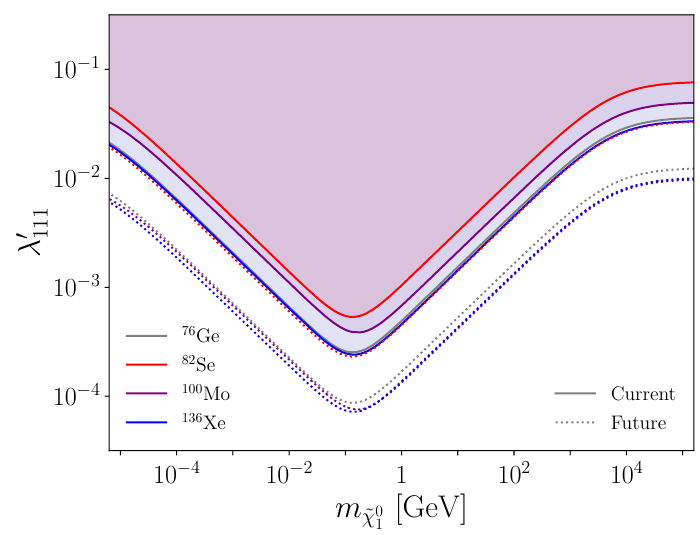
Figure 5 . Upper limits on λ 0 from the current lower limits on the 0 νββ decay half-life of 76 Ge 111 (GERDA), 82 Se (CUPID), 100 Mo (CUPID) and 136 Xe (KamLAND-Zen) for the benchmark super- partner masses m ˜ e = 700 GeV, m ˜ u = m ˜ = 1900 GeV and m ˜ g = 2350 GeV. The corresponding d R L L limits from the future projections are also shown by the dashed